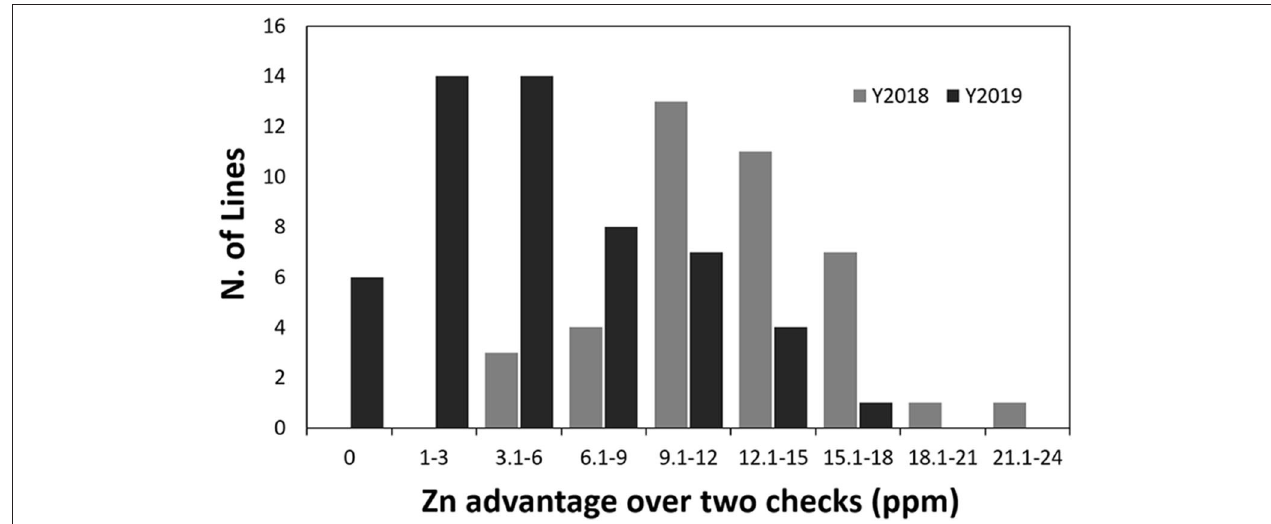
FIGURE 1 | Variation in grain Zn concentration among the biofortified analyzed lines, in relationship with the average grain Zn content from two non-biofortified field checks. Both the results from the 2018 and 2019 crop cycle are reported.